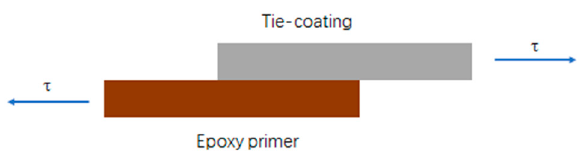
Figure 2. Schematic of shear test.